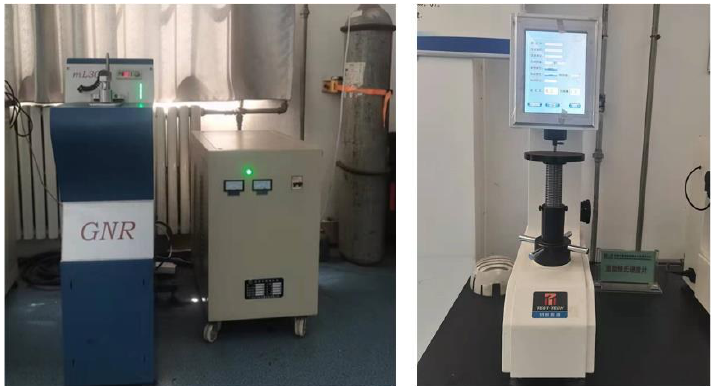
Figure 6. Preparation and mechanical properties analysis of AISI 321 patch tube.